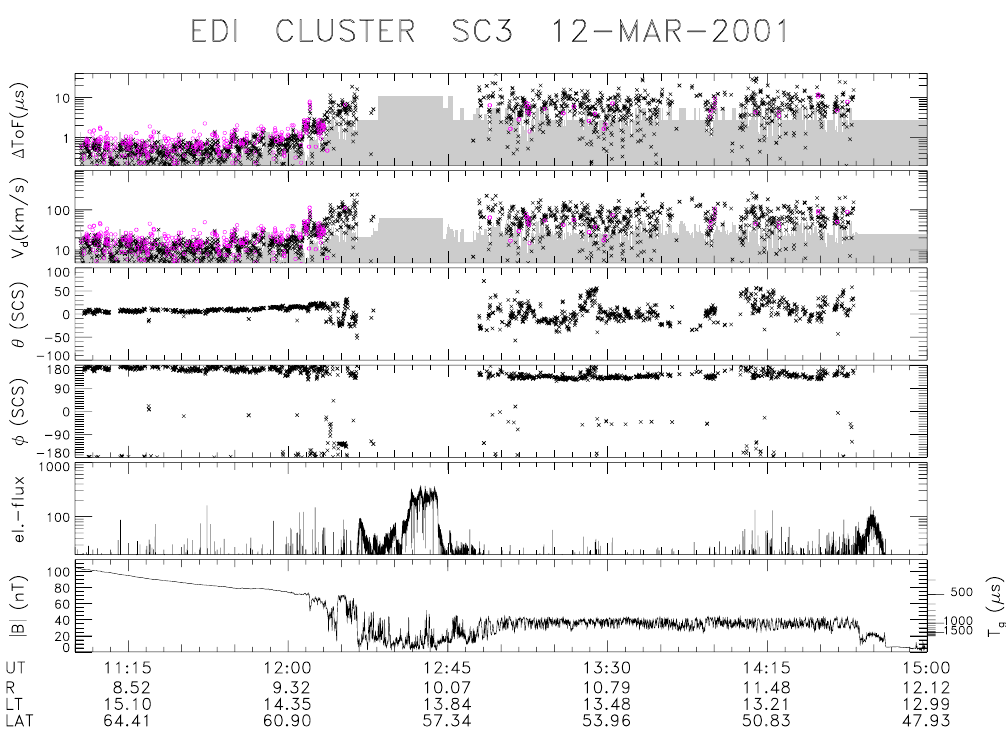
Fig. 8. Drift velocities on 12 March determined from the time-of-flight technique. The top panel shows the difference in the times-of-flight of the two beams, from which the magnitude of the drift velocity (second panel) is directly determined. There are two types of symbols in the top two panels (magenta-coloured circles and black crosses), which refer to the two different techniques to derive the 1 ToFs , as explained in the text. Points in the grey area, which is based on T chip / 8 as the error of the individual measurements, and on the number of points within each 3-spin interval, are not significant. The next two panels show the drift direction. The fifth panel shows the counts (per 2ms) received from ambient electron fluxes at 1keV and 90 ◦ pitch-angle, measured by EDI at the times when the beam was not detected. The bottom panel shows the spin-averaged magnetic field strength from FGM for reference. The scale on the right of that panel shows the electron gyro time computed from B